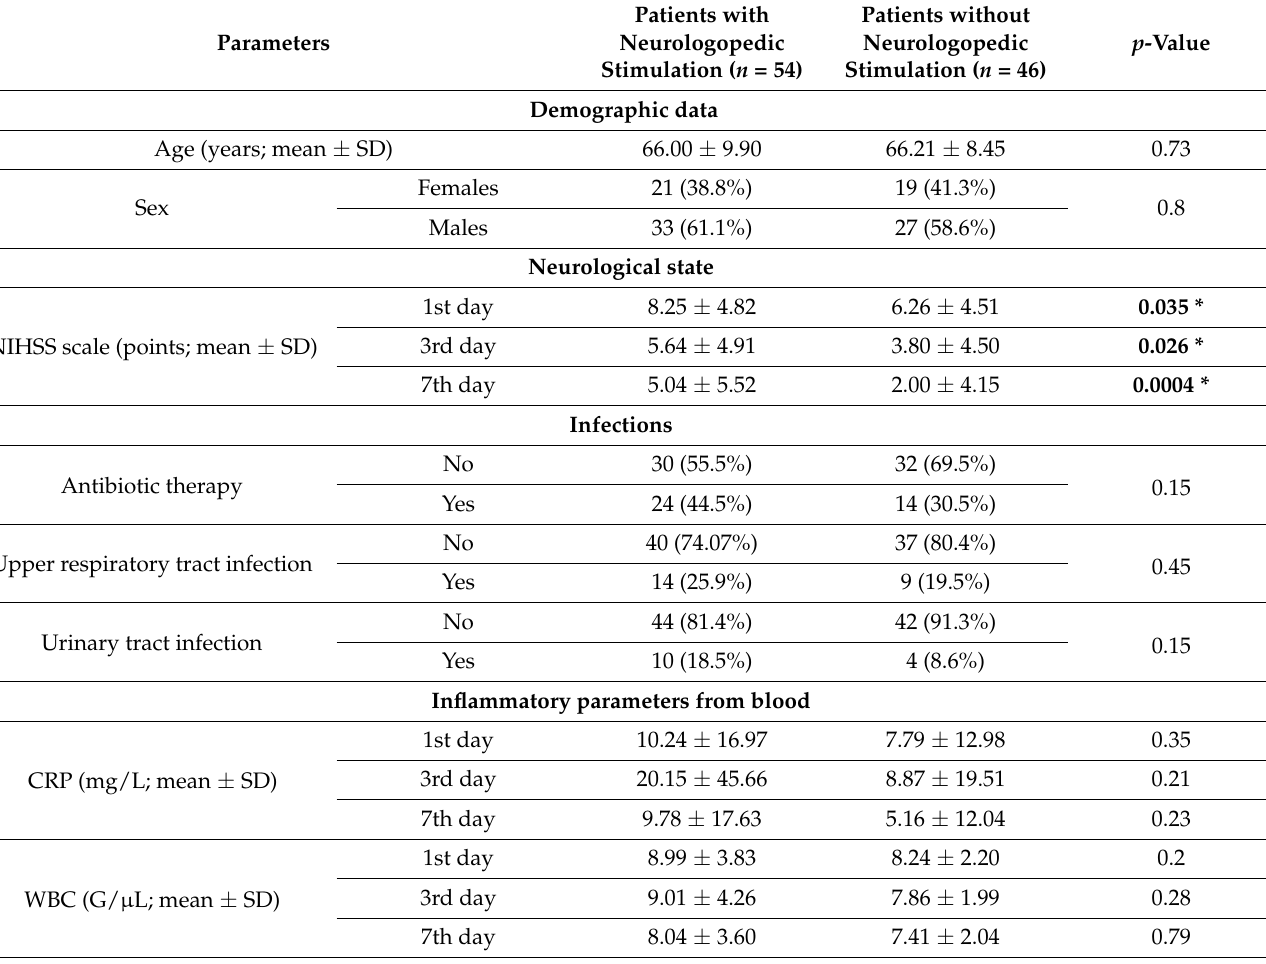
Table 4. Characteristics of stroke patients treated with and without neurological